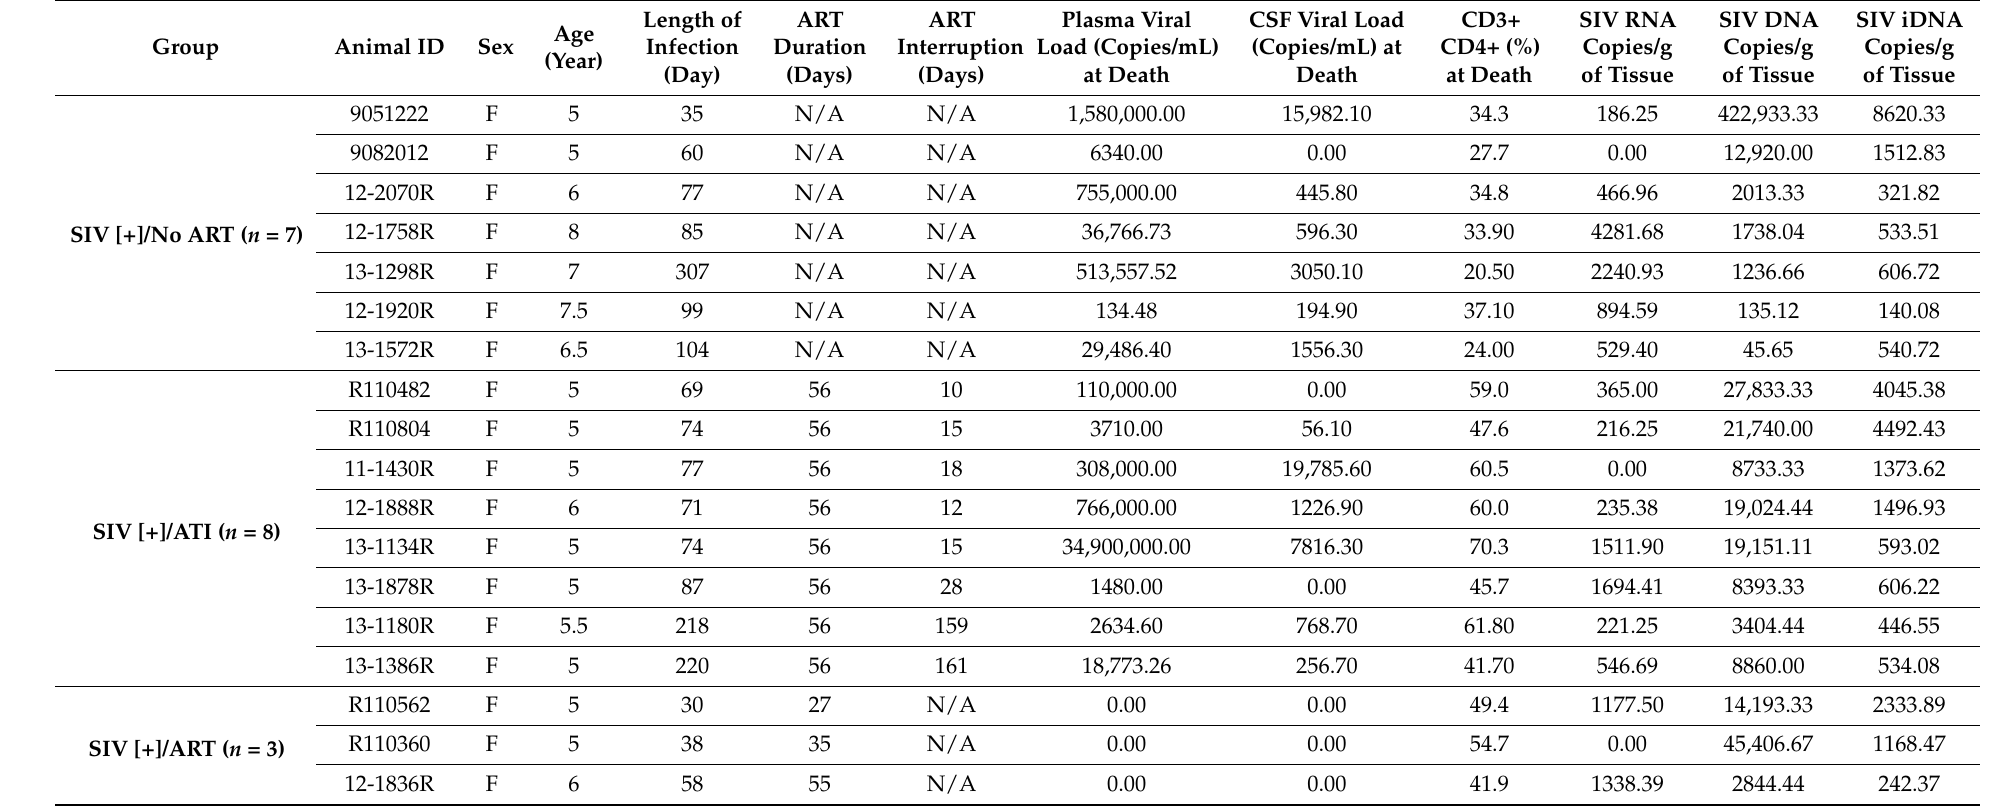
Table 2. Experimental features of SIV-infected non-human primate